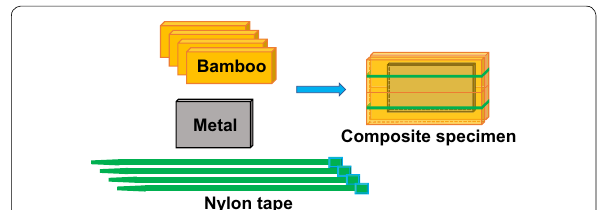
Fig. 1 Schematic illustration of preparing a bamboo–metal composite